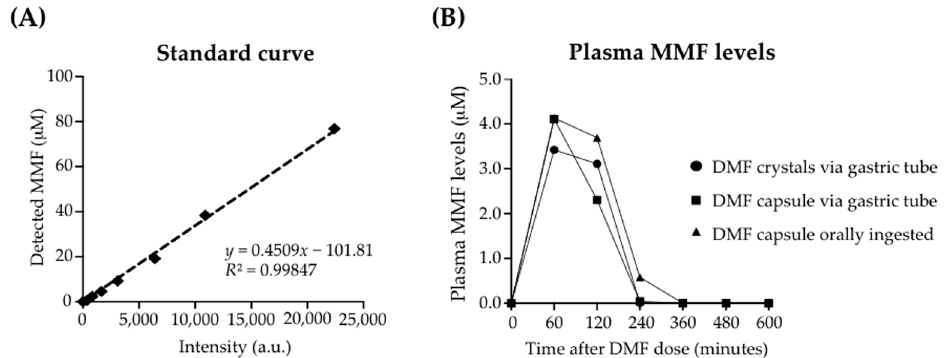
Figure 2 . Plasma monomethyl fumarate (MMF) levels in rhesus macaques after a single enteral dose of DMF (30 mg). ( A ) An eight-point standard curve was prepared using serial dilutions (MMF concentrations from 77 to 0.6 µ M). MMF was reconstituted in macaque plasma, which was previously separated from untreated rhesus macaque blood, and detected using liquid chromatography–mass spectrometry. ( B ) Each of three adult male rhesus macaques (8.1 kg, 9.1 kg, 11.4 kg) received a single 30 mg dose of DMF admixed in methylcellulose, either as a gelatin-coated capsule or as a crystalline suspension. One animal received the DMF capsule via a gastric tube. One animal received 30 mg of DMF embedded in a foodstuff, which was orally ingested. The remaining animal received a suspension of DMF crystals via a gastric tube. Plasma was separated from whole blood drawn at each indicated time point after the DMF administration. Samples were extracted with acetonitrile, dried, and reconstituted in acetonitrile solution. Each sample was assayed using LC–MS to establish the MMF content. Standard curves were prepared using monomethyl fumarate- 13 C-D3 for